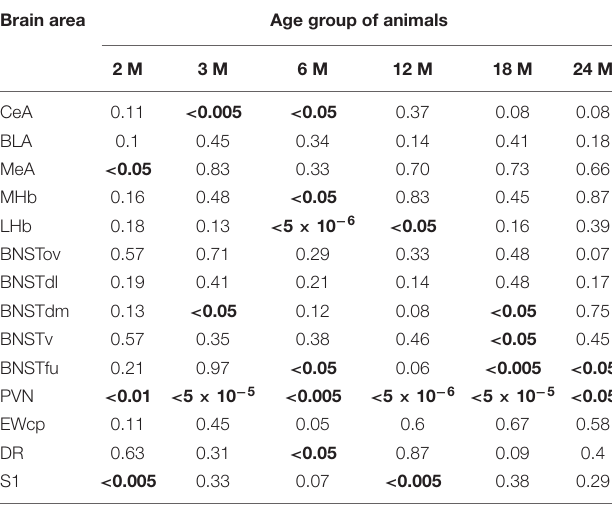
Comparisons of control vs. chronic variable mild stress (CVMS) groups in all age groups. Bold letters indicate the significant differences. Central (CeA), basolateral (BLA), and medial (MeA) nuclei of the amygdala; oval (BNSTov), dorsolateral (BNSTdl), dorsomedial (BNSTdm), ventral (BNSTv), fusiform (BNSTfu) divisions of the bed nucleus of the stria terminalis (BNST); medial- (MHb) and lateral- (LHb) habenula; PVN, paraventricular nucleus of hypothalamus;